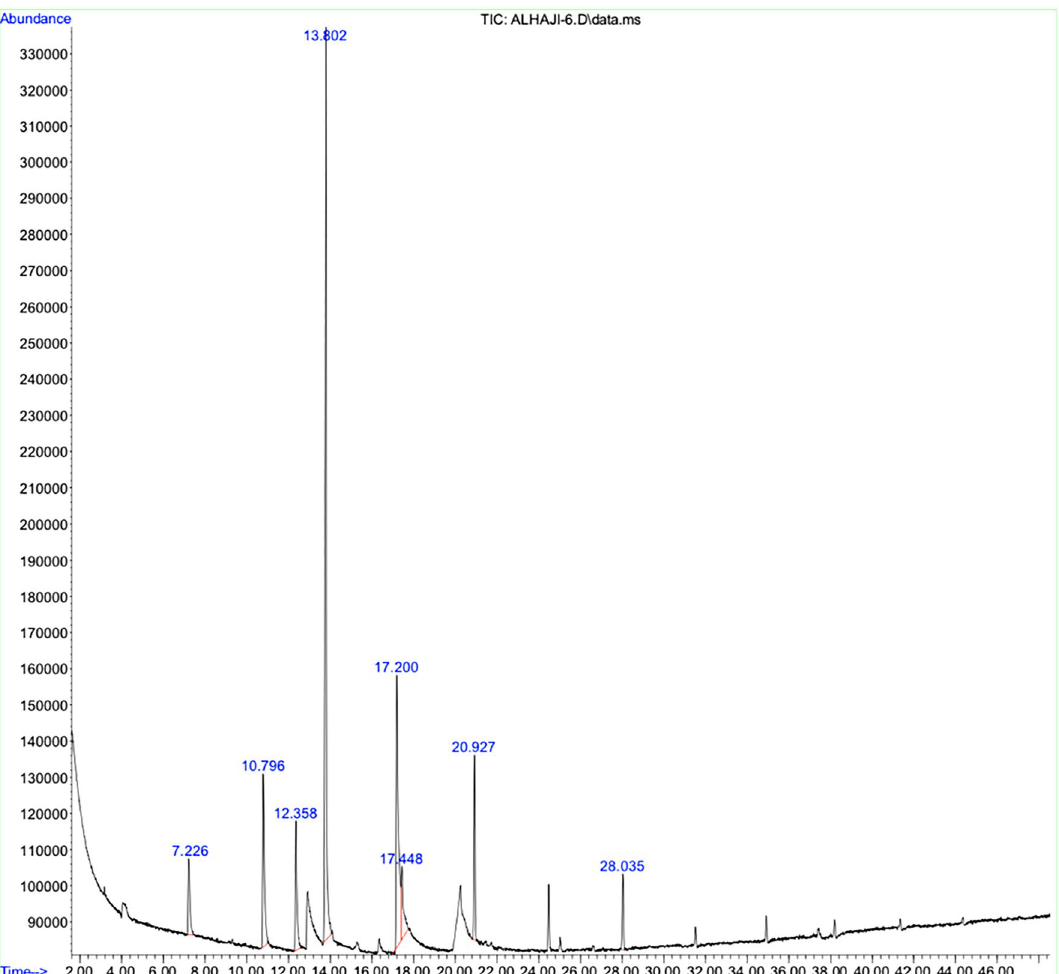
Figure 1. Gas chromatography spectra of biologically active compounds of Alhagi marurum